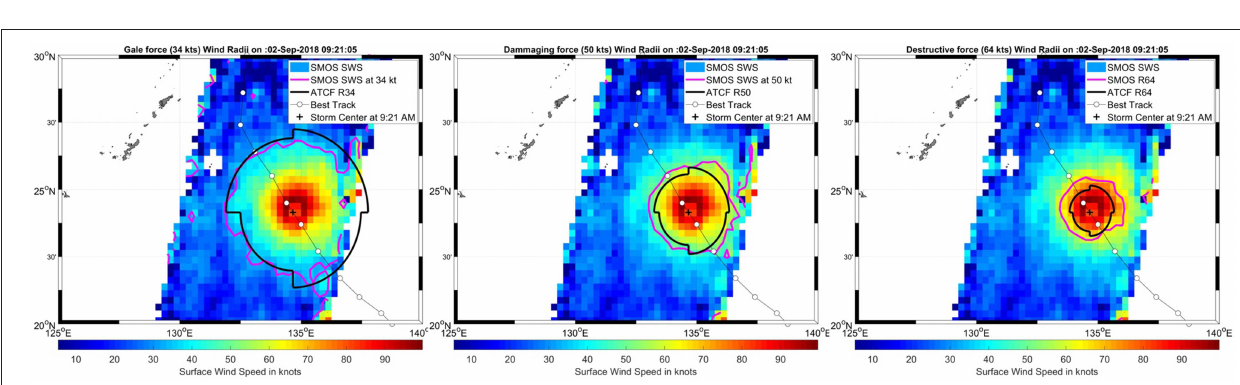
FIGURE 6 | Surface wind speed retrieved from SMOS data as the satellite swath intercepted Super-Typhoon JEBI on 02 SEP 2018. The wind speed contours from SMOS wind (pink) at 34 (left), 50 (middle), and 64 kt (right) are superimposed with Automated Tropical Cyclone Forecasting wind-radii forecasts (thick black). The direction of motion of the storm in the Best Track is from SE to